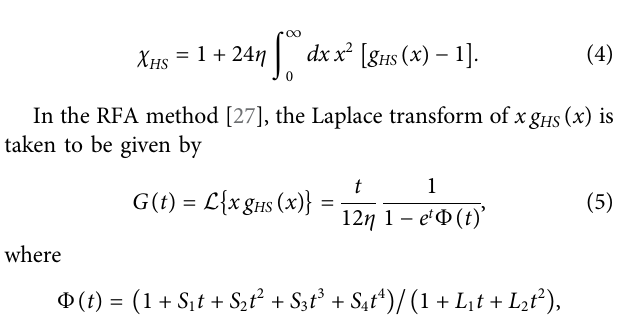
FIGURE 2 | Various subcritical isotherms of the parabolic-well fl uid for λ (cid:2) 1 . 75. The label TPT indicates that the results have been obtained using thermodynamic perturbationtheorywhilethelabelMDreferstoEvent-drivenMolecularDynamicssimulationresults.Theinsetshowsanenlargementoftheintermediatepackingfraction region for the isotherms with T p (cid:2) 1 . 0 and T p (cid:2) 1 .